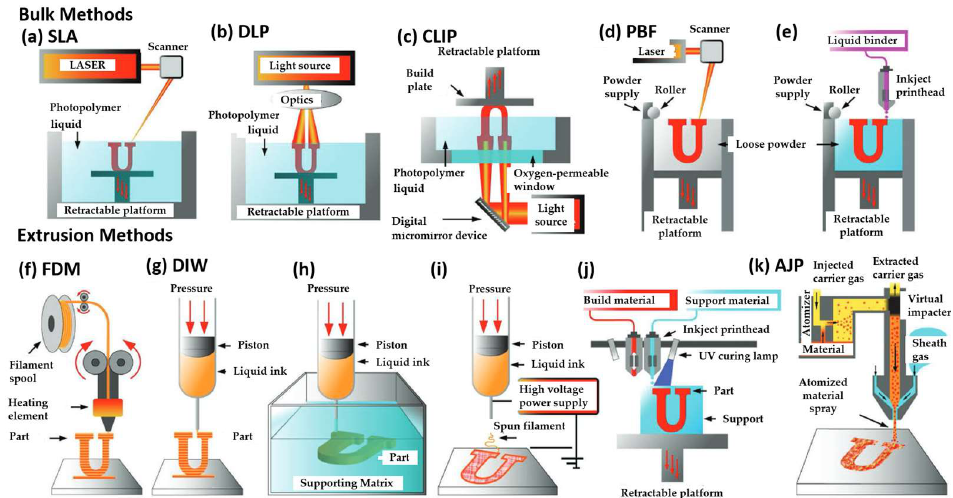
Figure 1. Schematics of bulk and extrusion 3D printing methods. ( a – e ) Bulk methods: ( a ) top-down laser stereolithography (SLA), ( b ) top-down digital projection lithography (DLP), ( c ) continuous liquid interface production (CLIP), ( d ) powder bed fusion (PBF), and ( e ) binder jet. ( f – k ) Extrusion methods: ( f ) fused deposition modeling (FDM), ( g ) direct ink writing (DIW), ( h ) sacrificial/embedded printing, ( i ) electrospinning, ( j ) direct inkjet printing, and k) aerosol jet printing (AJP). Reprinted with permission from [9].